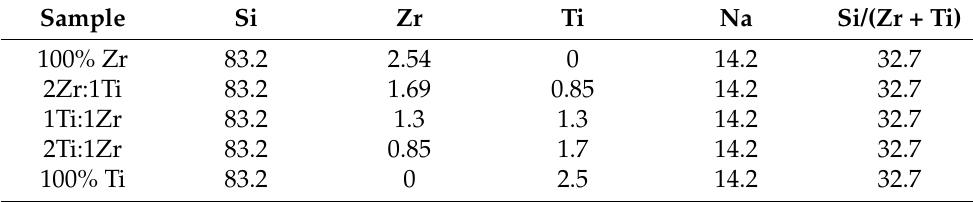
Table 9. Elemental composition (atomic ratio) in synthesizing